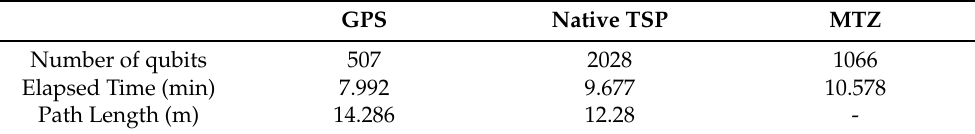
Table 4. A regular polygon layout has been taken where the cities occupy the positions of the nodes [50] for the elaboration of all tables. In this scenario of 10 cities, we set comparison with the 3 models, MTZ, native TSP and GPS. The comparison is based on the number of times to find the solution, the distance travelled, and the number of qubits. We can appreciate the good performance of our GPS model, and above all the savings it offers us in the number of qubits. GPS Native TSP MTZ Number of qubits 363 1210 770 - Table 5. A regular polygon layout has been taken where the cities occupy the positions of the nodes [50] for the elaboration of all tables. In this scenario of 12 cities, we set comparison with the 3 models, MTZ, native TSP and GPS. The comparison is based on the number of times to find the solution, the distance travelled, and the number of qubits. GPS Native TSP MTZ